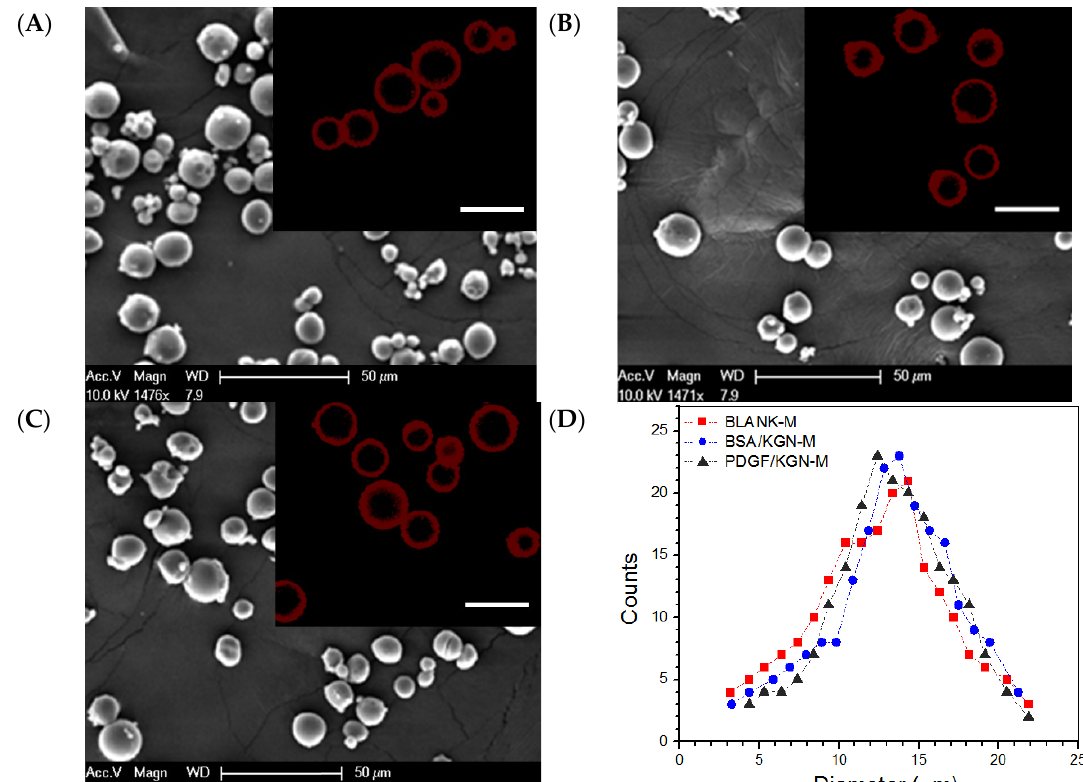
Figure 1. SEM images for BLANK-M MPs ( A ), BSA/KGN-M MPs ( B ) and PDGF/KGN-M MPs ( C ) (inserted fluorescence images denote the shell layer of MPs, scale bar: 20 μ m); and size distribution ( D ) for three kinds of MPs.